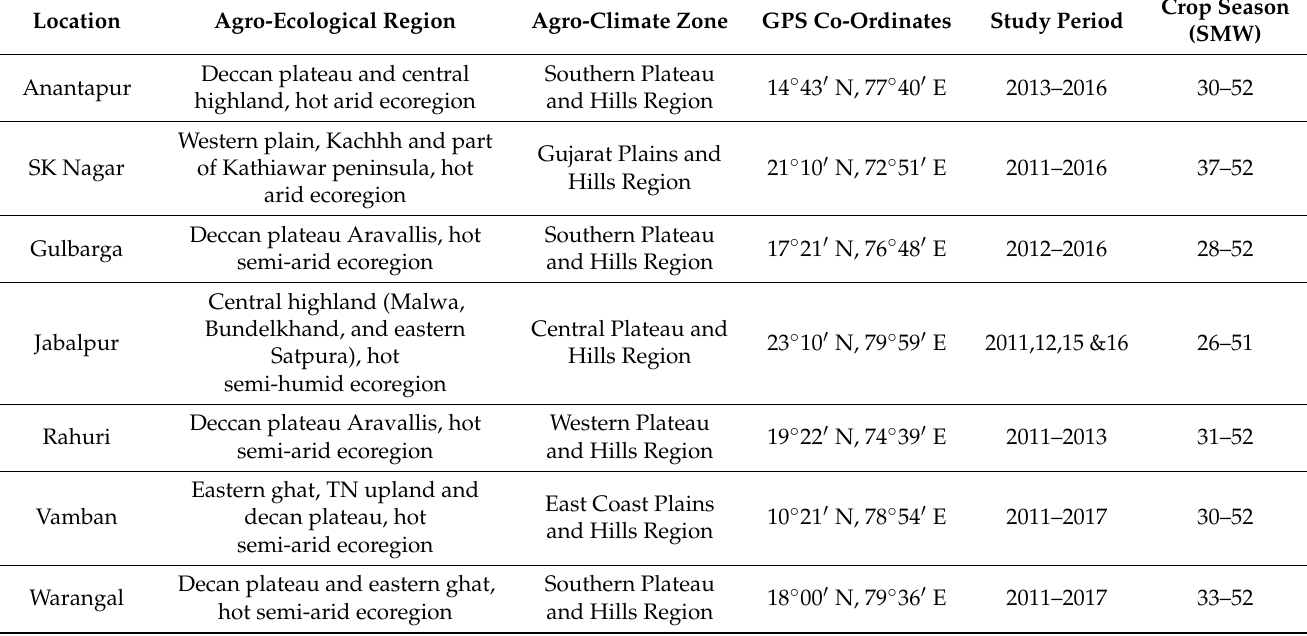
Table 1. Details of study